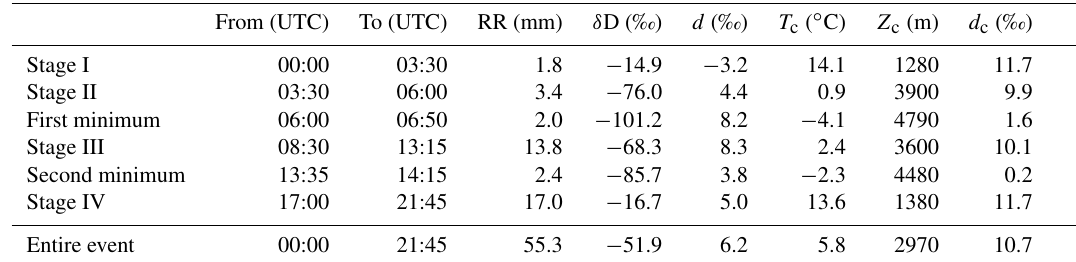
Table 1. The observed rain rate (RR) and isotope compositions ( δ D, d -excess) and the corresponding model estimate of condensation temperature ( T c ), condensation height ( Z c ), and d -excess of the surface precipitation ( d c ) during the AR event on 7 December 2016 in Bergen. The model estimates are calculated using the observed δ D values of the surface precipitation, according to a Rayleigh fractionation model of Jouzel and Merlivat (1984). Supersaturation over ice S i is assumed to occur during ice formation and is represented with a linear formula S i =1 − 0 . 004 T ( T in ◦ C) after Risi et al. (2010). Input conditions have been taken from global average conditions according to Craig and Gordon (1965) as T 0 = 20 ◦ C, RH 0 =0 . 75, δ 18 O 0 =-13‰, and δ D 0 = −